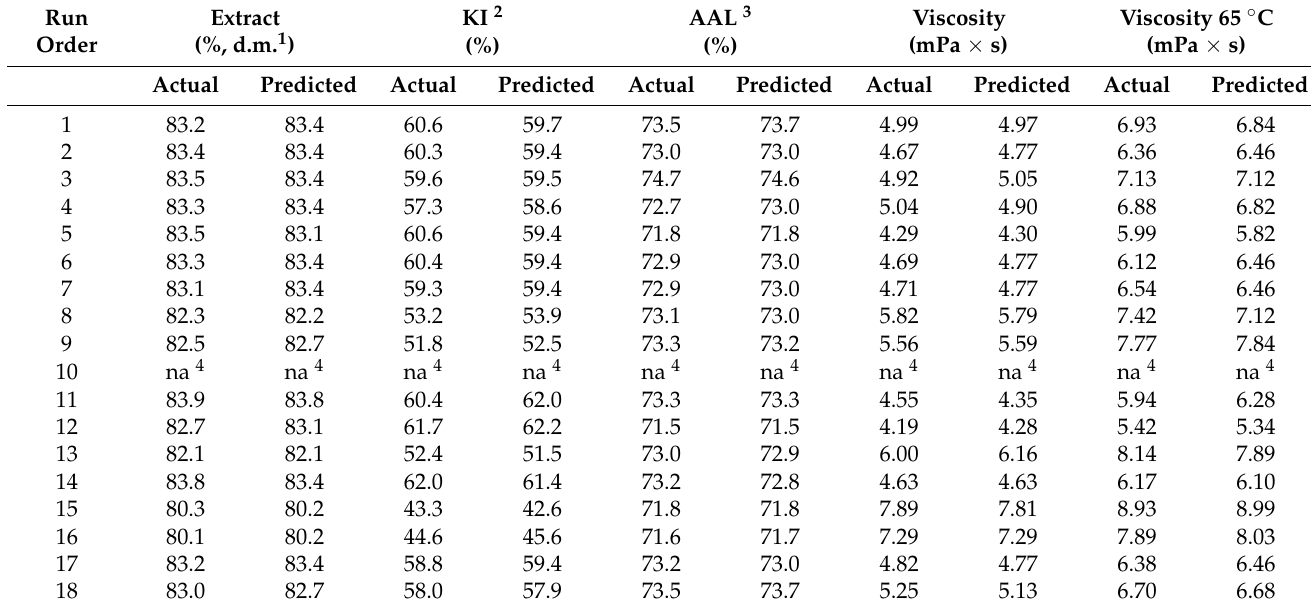
Table 3. Comparison between actual and predicted responses using